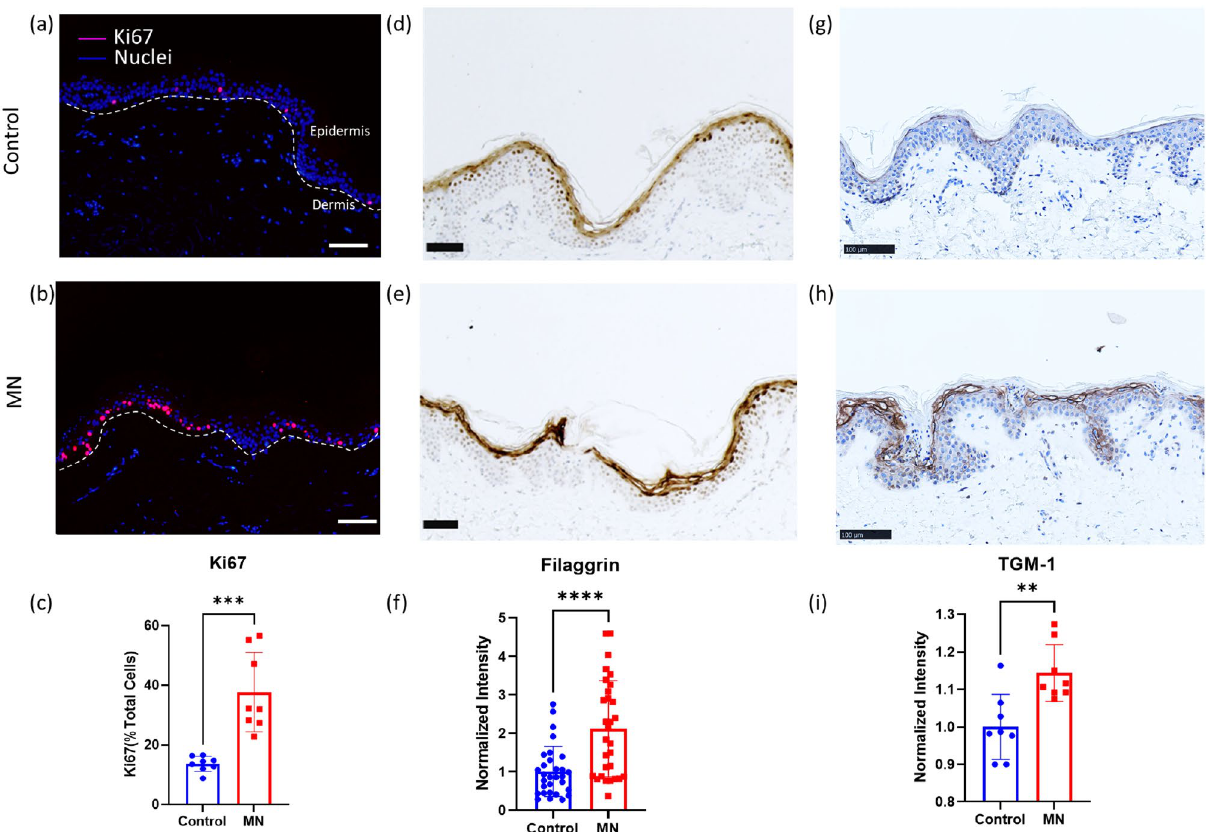
Figure 2. Epidermal regeneration of ex vivo tissue with and without microneedling procedure. Keratinocytes from control ( a ) and MN ( b ) groups express the proliferation marker Ki67 on Day 6 (pink, N = 8, 2 fields of view from 2 biological samples per treatment, 2 donors). The nuclei were stained with DAPI (blue). White dashed lines indicate the dermal-epidermal boundary. ( c ) Basal cell proliferation level was quantified based on the